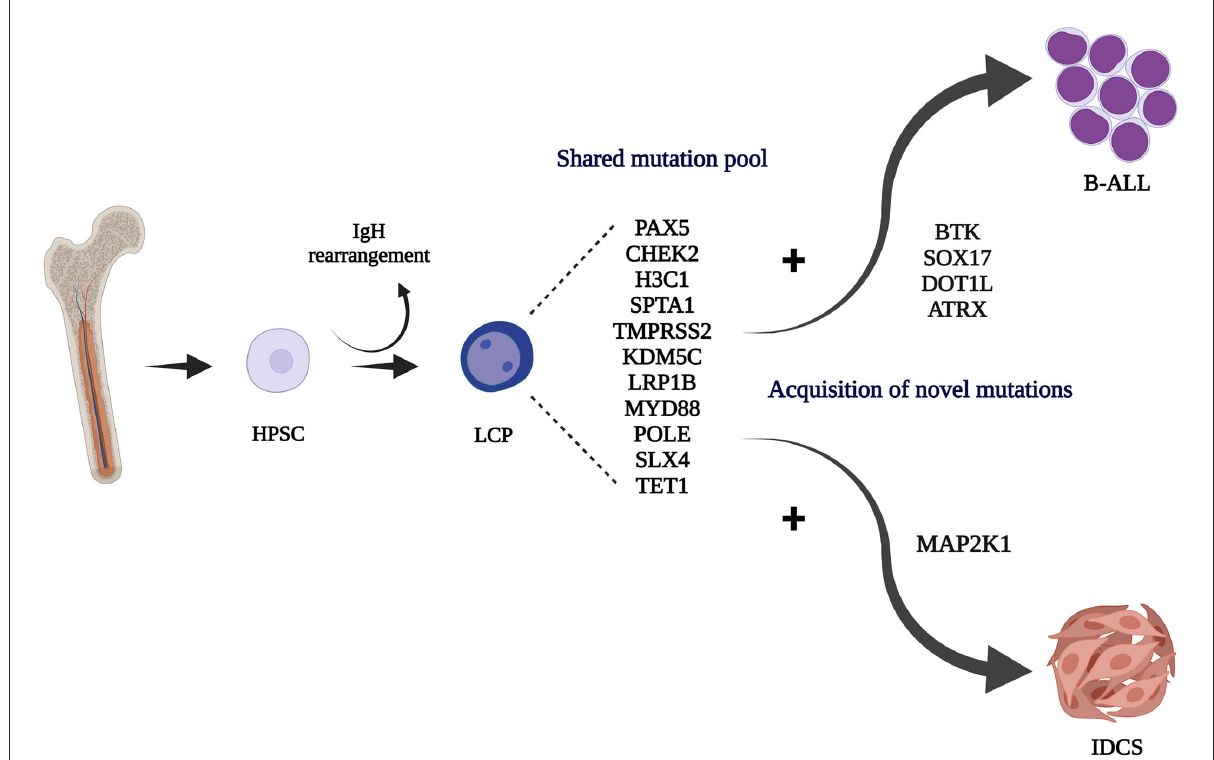
FIGURE3 Hematopoietic stem/progenitor cell (HPSC) origin of the IgH rearranged common lymphoid committed tumor progenitor (LCP). Acquisition of different driver mutations may contribute to the development of the B-ALL and IDCS clones. Created with BioRender.com.